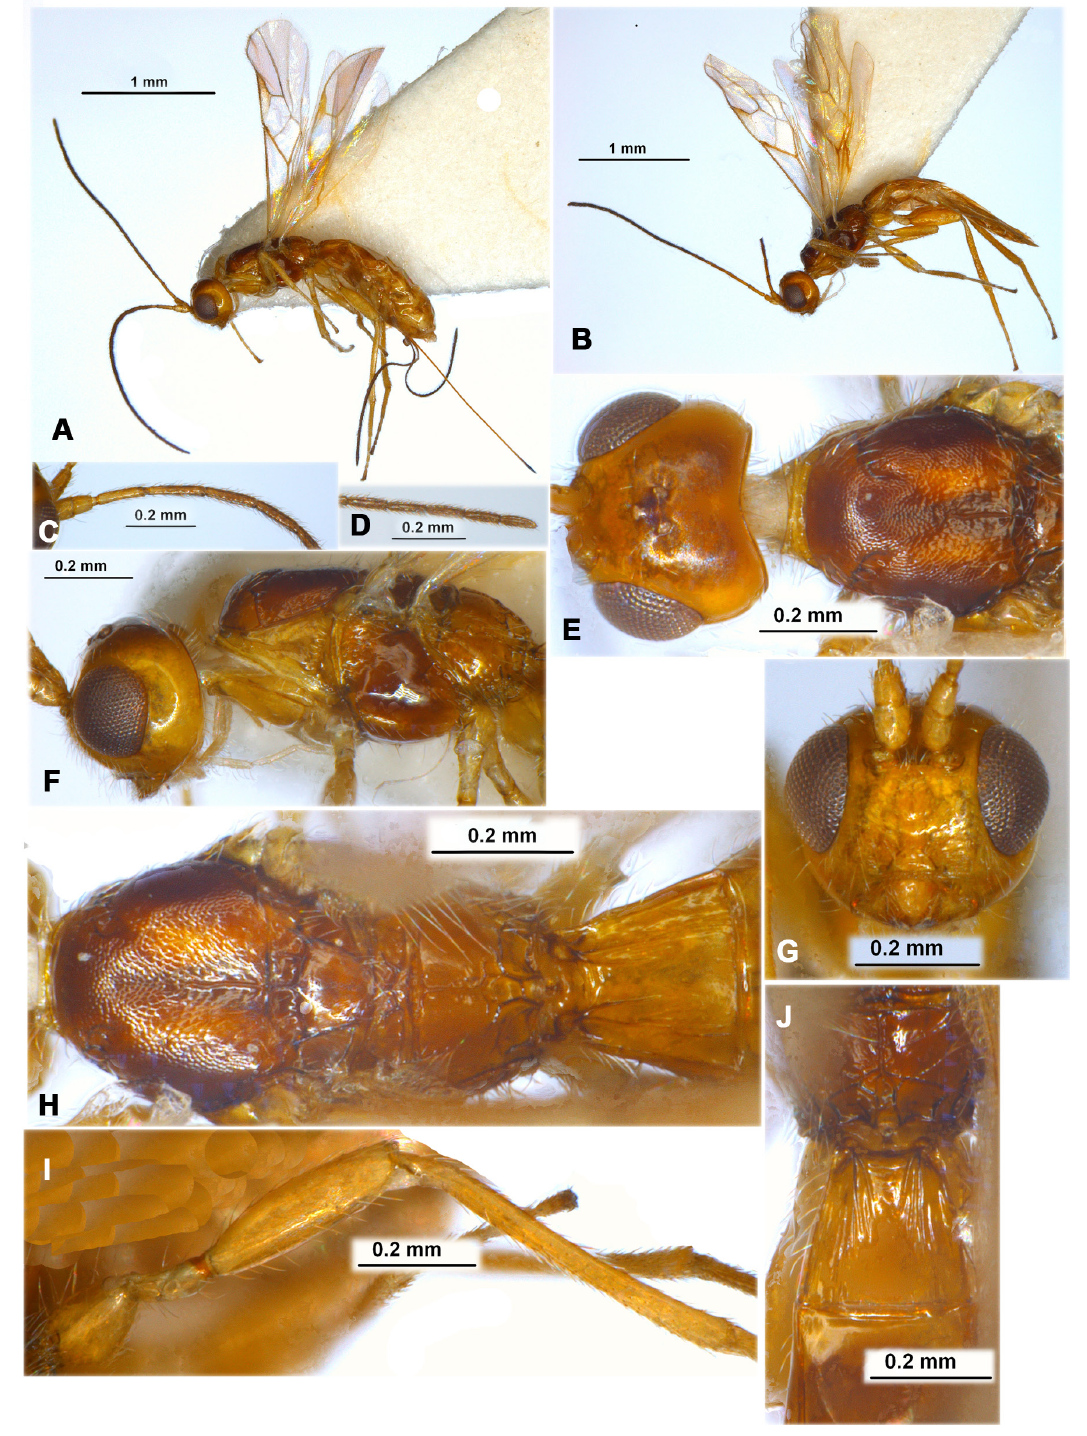
Fig. 63. Aivalykus microaciculatus Ranjith & Belokobylskij, 2020, paratypes. A , C-J . ♀ (RMNH). B . ♂ (RMNH). A–B . Habitus, lateral view. C . Basal segments of antenna. D . Antennal segments of antenna. E . Head and mesoscutum, dorsal view. F . Head and mesosoma, lateral view. G . Head, front view. H . Mesosoma and first metasomal tergite, dorsal view. . I . Hind leg. J . Propodeum and first metasomal tergite, dorsal